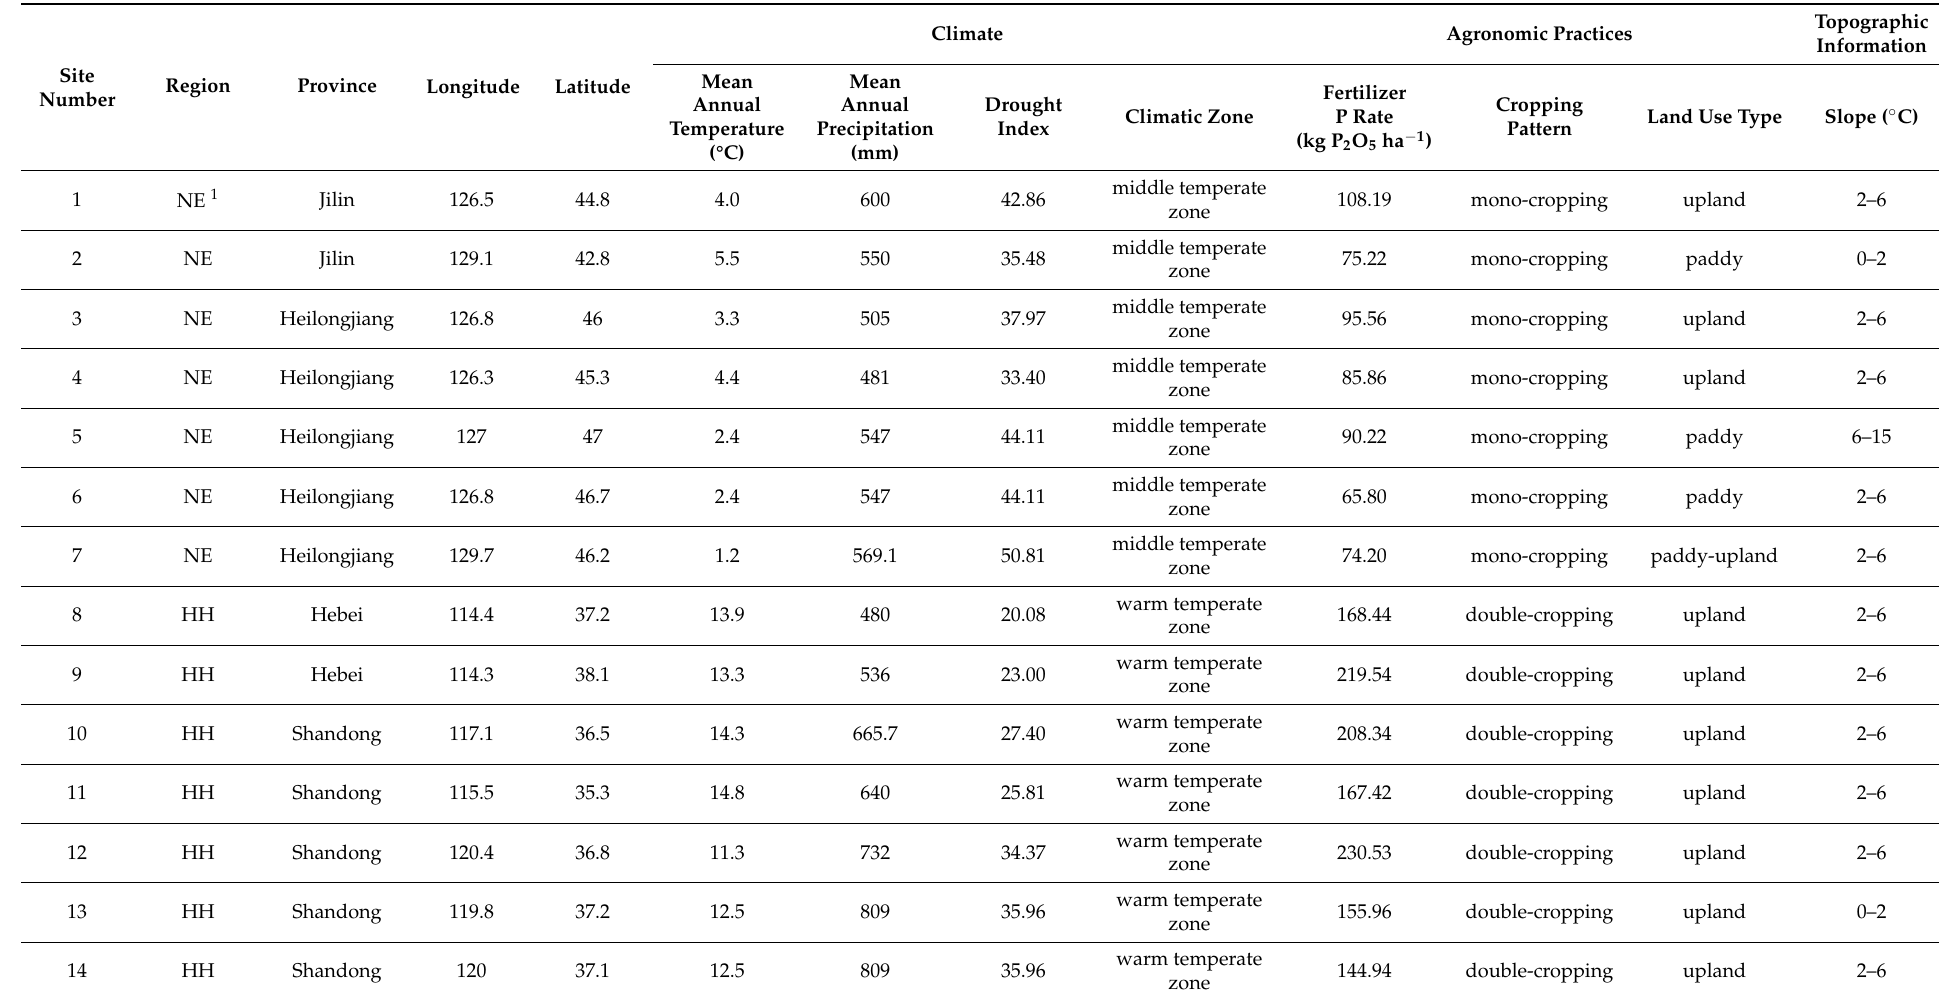
Table A2. Detailed information of field experimental